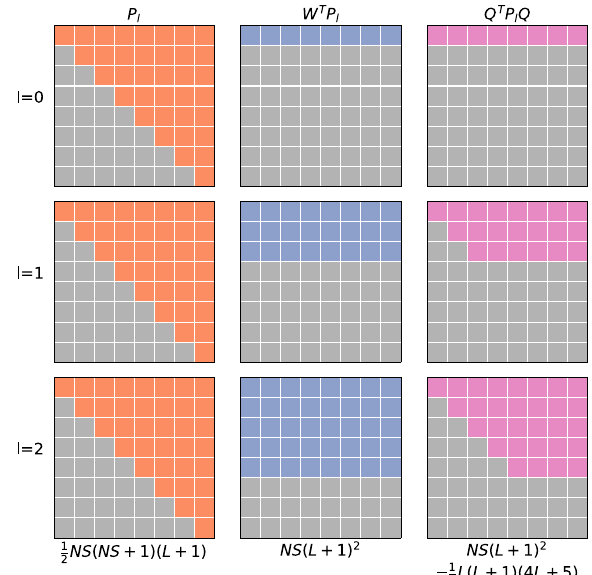
Fig. 1 Illustration of the W T P l compression scheme. Moving from left to right P l , W T P l and Q T P l Q are shown for l = 0, 1, 2 and NS = 8. Typically NS will be signi fi cantly larger than shown here. Only the elements shown in colour need to be stored to determine all remaining elements which are shown in grey. The total length of each descriptor is listed